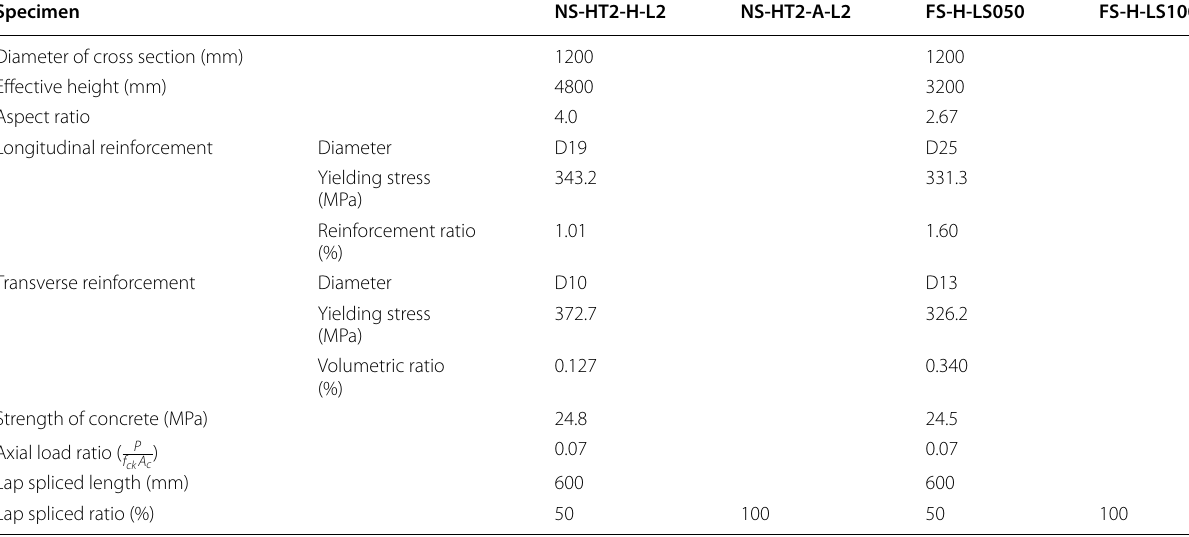
Table 1 Properties of the reinforced concrete column specimens.